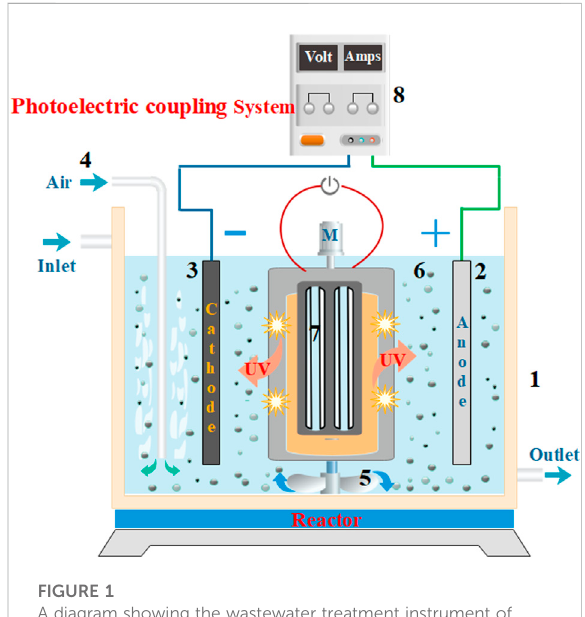
FIGURE 1 A diagram showing the wastewater treatment instrument of the photoelectrical system with a three-dimensional electrode. (1) Water tank, (2) DSA anode, (3) Titanium cathode, (4) Gas tube,